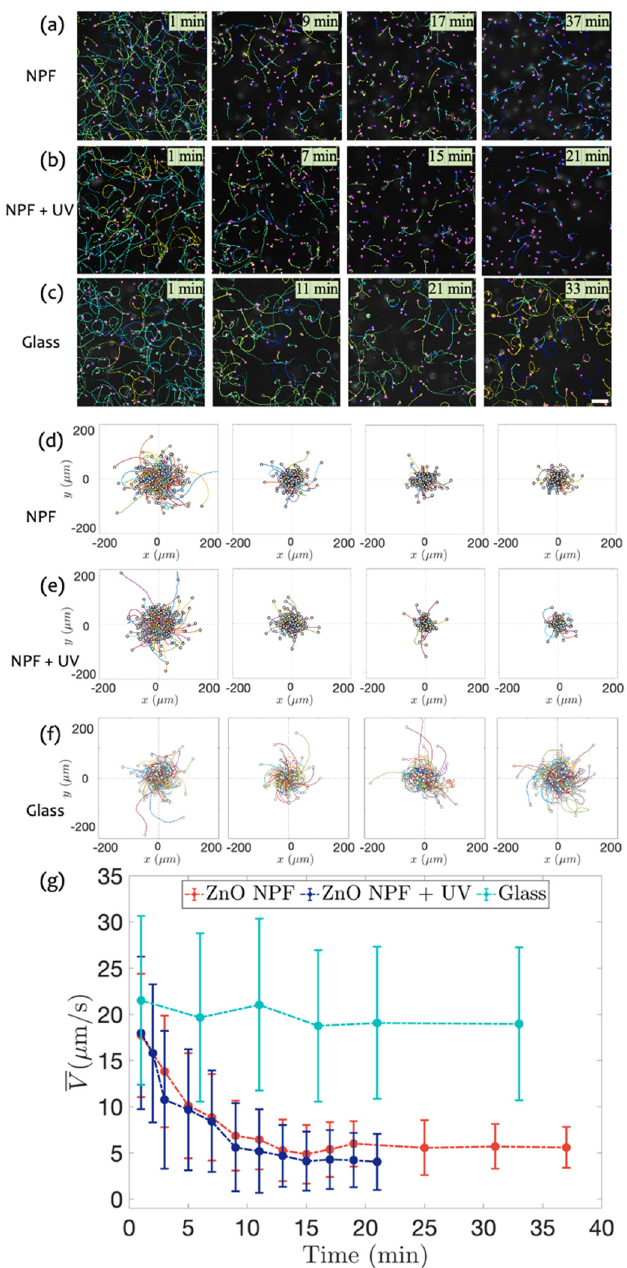
Figure 4. Swimming on nanoparticle film of ZnO. ( a – f ) Snapshots and trajectories of tracked bacteria on NPF and glass with and without UV irradiation, respectively. ( g ) Mean swimming speed on NPF with and without UV irradiation over time. The scale bar represents 30 μm .